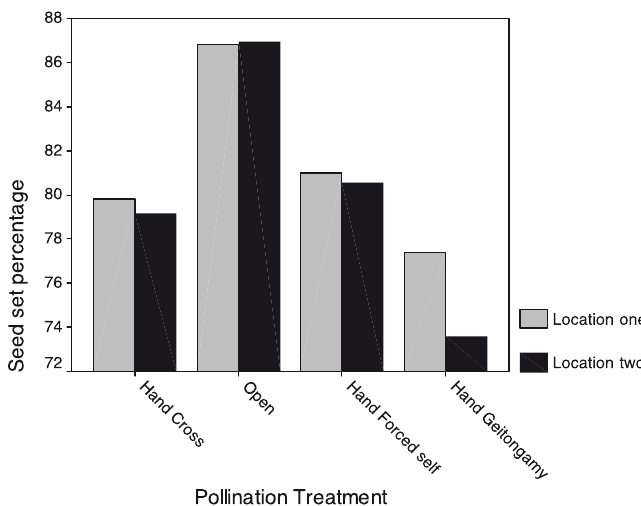
Fig. 3 - Nigella sativa seed set percentage upon pollination treatments in location A and B season one.